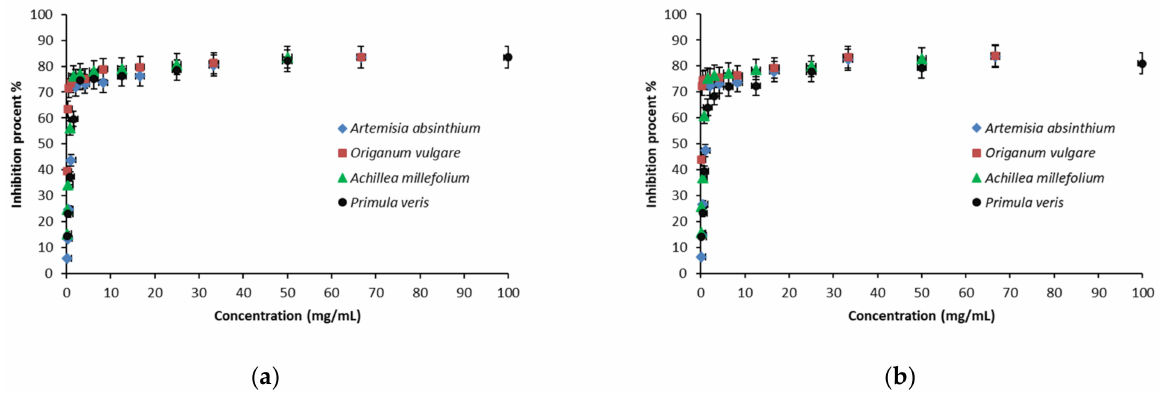
Figure 1. DPPH inhibition percentage of the ethanolic extracts after 20 min of incubation ( a ), and after 50 min of incubation ( b ). Values are means of three replicates ± standard deviation.